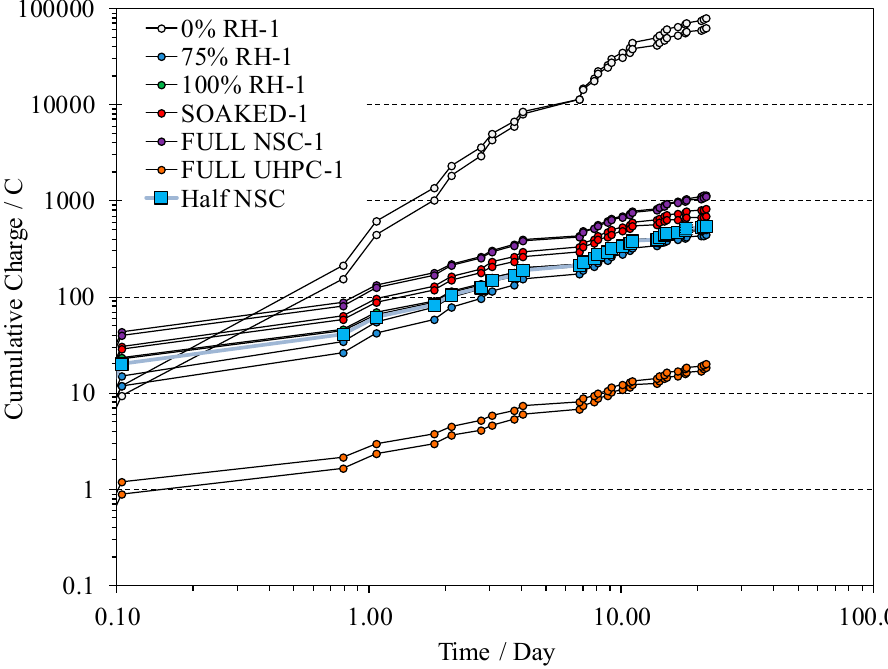
Figure 5. Cumulative charge passed through specimens with different substrate exposures.